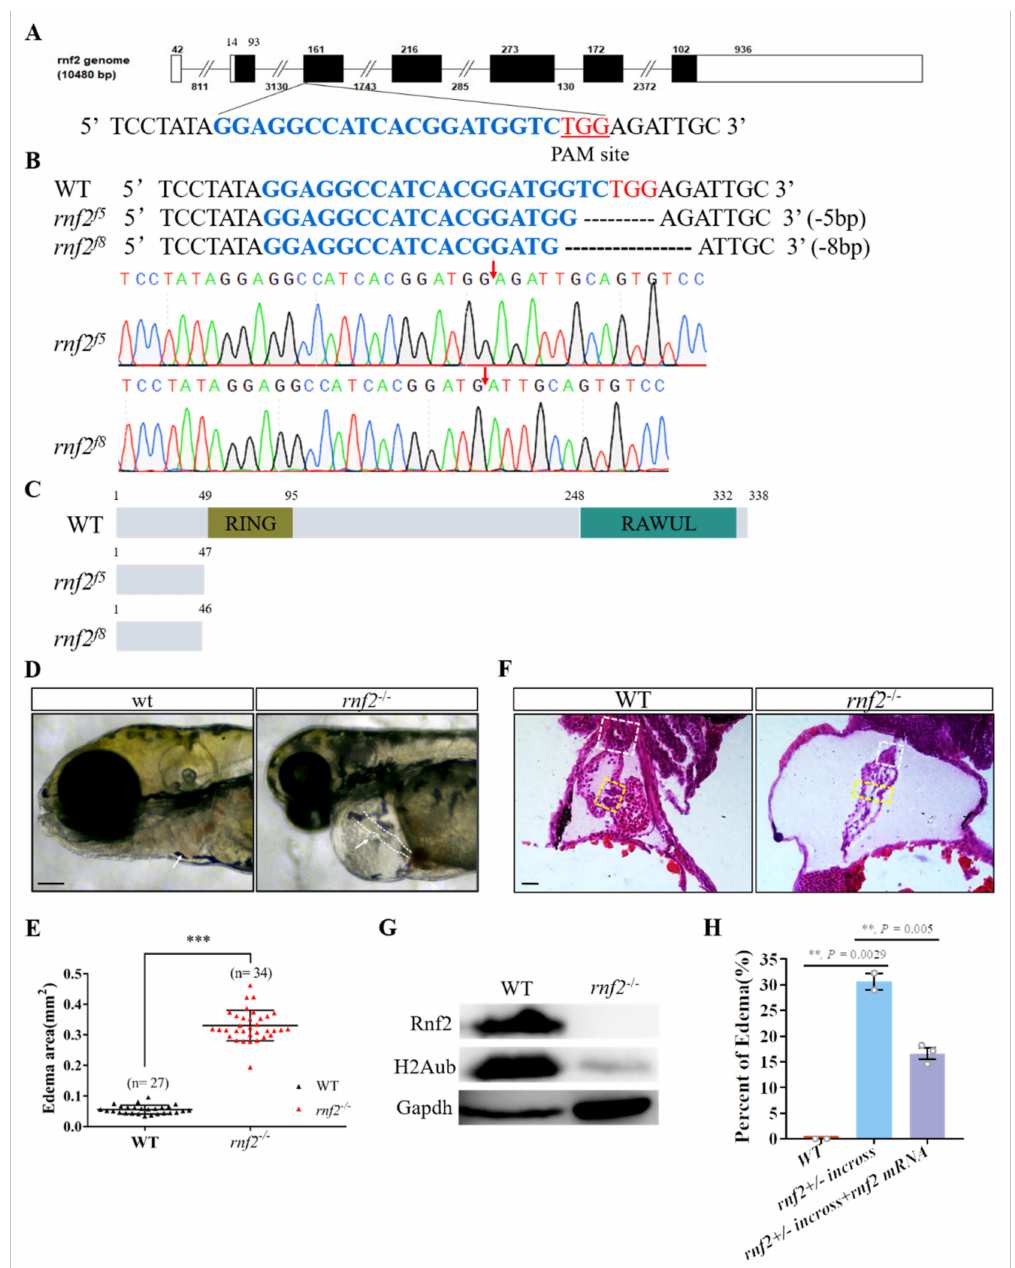
Figure 1. Rnf2-null zebrafish mutant displayed severe cardiac defects. ( A ) The target site (sequence highlighted in blue) is located in exon 3. The PAM site is underlined and highlighted in red; ( B ) DNA sequencing identified that two mutant alleles carried a 5 bp ( rnf2 f5 ) and 8 bp ( rnf2 f8 ) deletion respectively. The deletion sites are indicated by red arrows; ( C ) Schematic diagram of the wild-type and mutant Rnf2 proteins. Zebrafish wild-type Rnf2 contained an N-terminal Ring-finger domain (yellow) and a C-terminal RAWUL domain. The two mutant proteins were truncated before the RING-finger domain; ( D ) The rnf2 − / − larvae displayed severe pericardia edema. The hearts are indicated by white arrows, the stringy heart in rnf2 − / − is depicted by white dotted lines, scale bar: 0.2 mm; ( E ) Scatter plot showing the sectional area of edema in wild-type (black) and rnf2 − / − (red). ( F ) Histological sections of 4 dpf heart, boxes in yellow indicate the AVC and valves, white boxes indicate the bulbous arteriosus, scale bar: 50 µ m, n(WT) = 2, n ( rnf2 − / − ) = 3; ( G ) Western blot verified the deletion of Rnf2 protein. Gapdh was set as internal reference; ( H ) Bar graph showing the percentage of embryos with edema. **, p < 0.01; ***, p < 0.001; n, sample